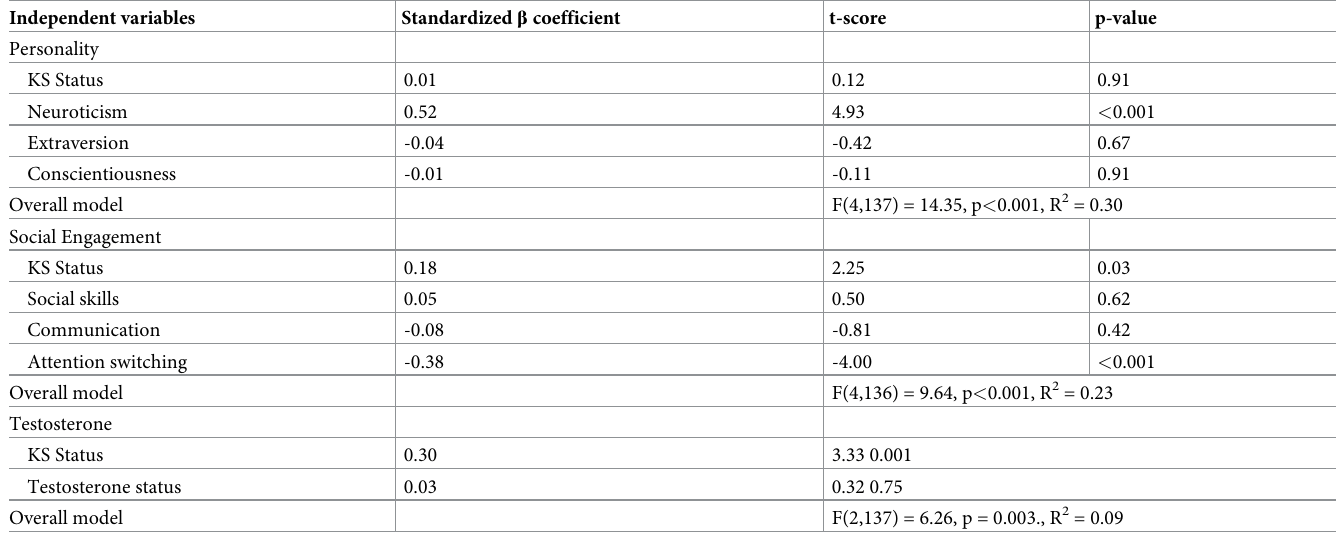
Table 3. Regression models predicting anxiety.